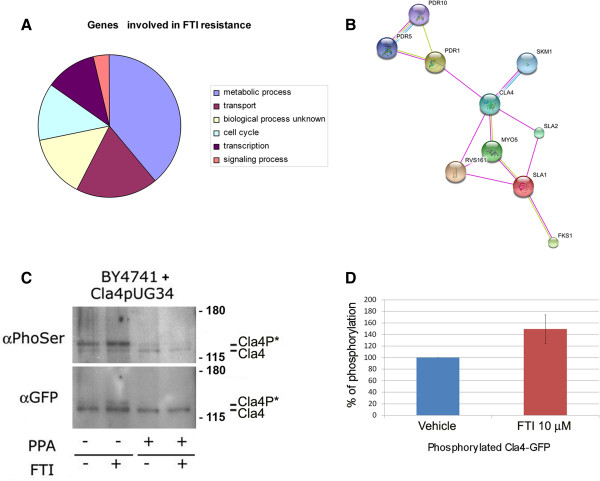
p-21 activated kinases or ABC transporters are among the genes whose deletion increases FTI sensitivity of yeast cells. A. Pie visualization of the 64 genes identified by drug sensitivity screening as putative hits. Super GO Slim tool Biological Process Binning was used for clustering the FTI hypersensitive hits. B. The network analysis of hypersensitive strains carrying deletions of CLA4, SKM1, PDR10 was performed for known and predicted protein-protein interactions using STRING (http://string-db.org/). The evidence view is shown, different line colors represent the types of evidence for the association. High confidence (score 0.700) excluding the text mining settings were used as parameters. C. Immunoblot analysis of the immunoprecipitates obtained from BY4741 cells expressing GFP-Cla4. αPhoSer = anti-phosphoserine Q5 antibody; αGFP = anti-GFP antibody. (+) indicates addition, (−) no addition. PPA = phosphatase lambda. FTI = 10 μM FTase I inhibitor. Numbers indicate MW. Expected protein positions are indicated. D. The graph shows the relative amount of phosphorylated versus unphosphorylated Cla4 relative to vehicle. The relative protein levels are expressed in percentage (%). The amount of control (vehicle-treated cells) was considered as 100%. Error bars indicate means ± SD of at least 3 replicates (n = 3).